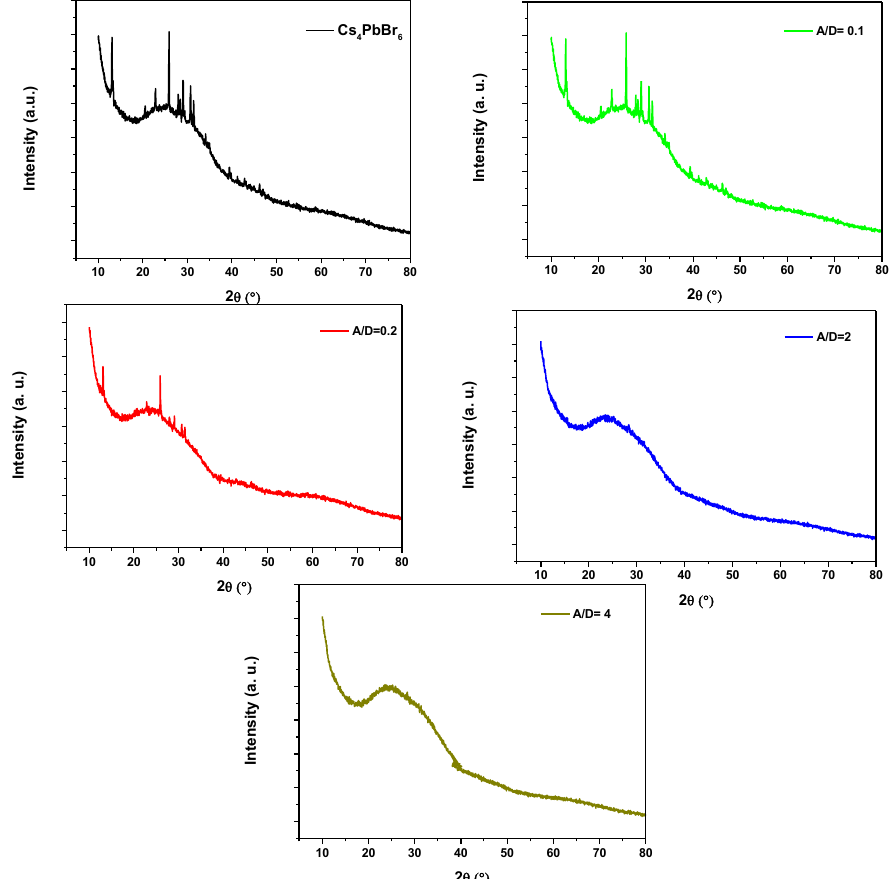
Figure 1. XRD diffractograms of 0-D Cs 4 PbBr 6 perovskite thin films with various 2-methoxy-5-(2- Figure 1. XRD di ff ractograms of 0-D Cs 4 PbBr 6 perovskite thin films with various 2-methoxy-5- (2-ethyl-hexyloxy)-1,4-phenylene-vinylene (MEH-PPV) ratios. ethyl-hexyloxy)-1,4-phenylene-vinylene (MEH-PPV) ratios. The morphology of the pristine 0-D Cs 4 PbBr 6 and Cs 4 PbBr 6 / MEH-PPV hybrid thin films